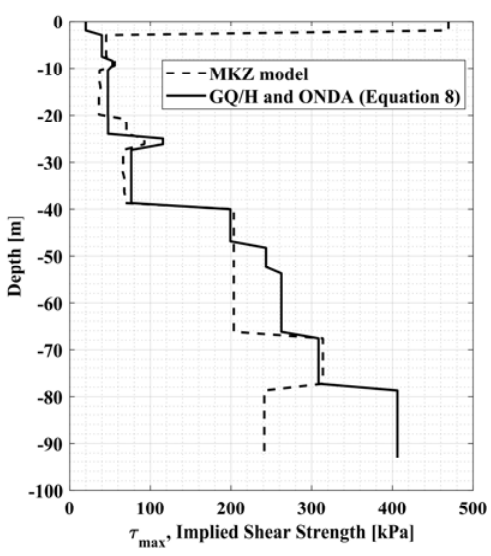
Figure 12. Implied shear strength profiles.